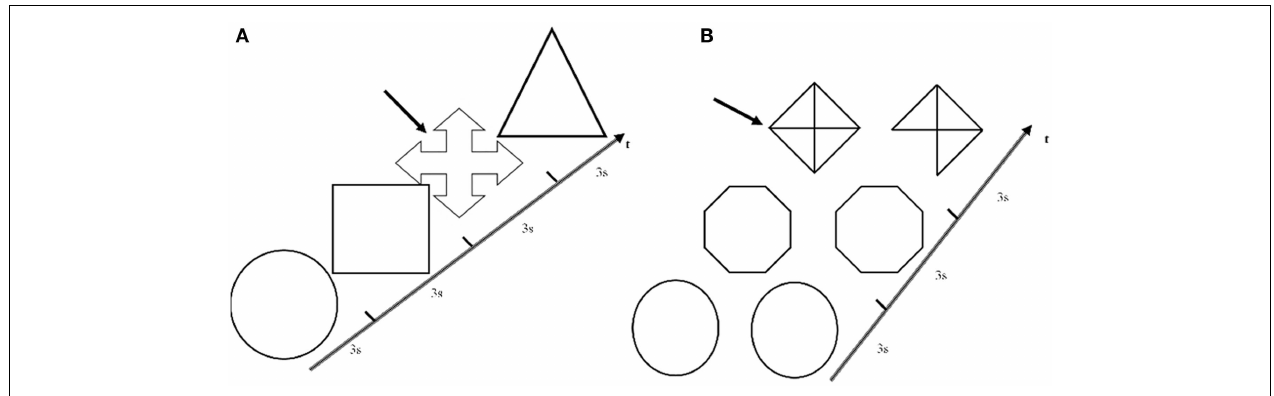
sequence presented in the visuospatial task. Subjects were asked to press the key when coupled figures resulted different (as indicated by the arrow). For both tasks, seven slices lasting 3s were presented during each